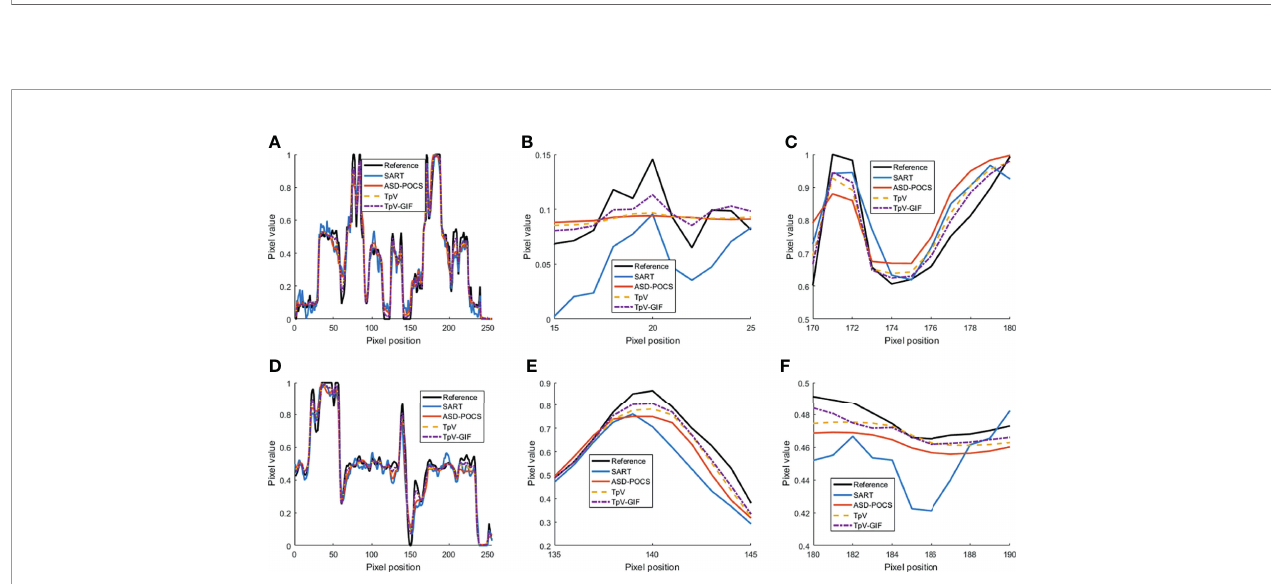
FIGURE 7 | Pro fi le curve images. (A) The full voxel curve of the 128th row of the 133rd slice; (B, C) A partial enlargement of (A, D) the axial voxel curve of the 128th row and 128th column of all faults; (E, F) Partial enlargement of (D) .